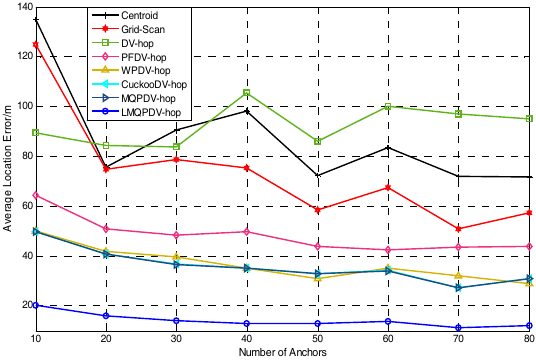
Figure 7. The effect of the number of anchors on error for WSN#1. Figure 7. The e ff ect of the number of anchors on error for